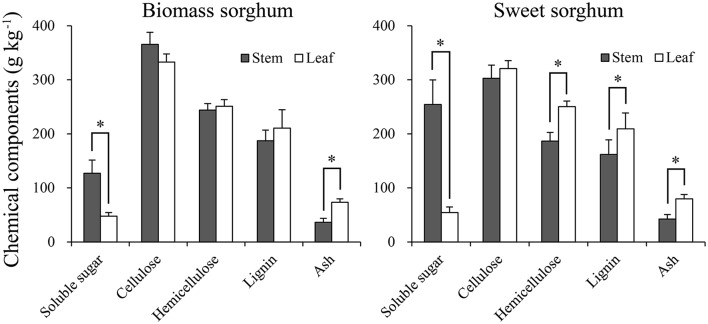
Chemical components partitioning of biomass and sweet sorghum into stem and leaf averaged across all hybrids used at the experimental sites of sub-humid climate and saline-land (SHS), semi-arid climate and wasteland (SAW), and sub-humid climate and cropland (SHC). Asterisks indicate significant differences within stem and leaf for each component at the p < 0.05 level. Vertical bars represent standard errors.